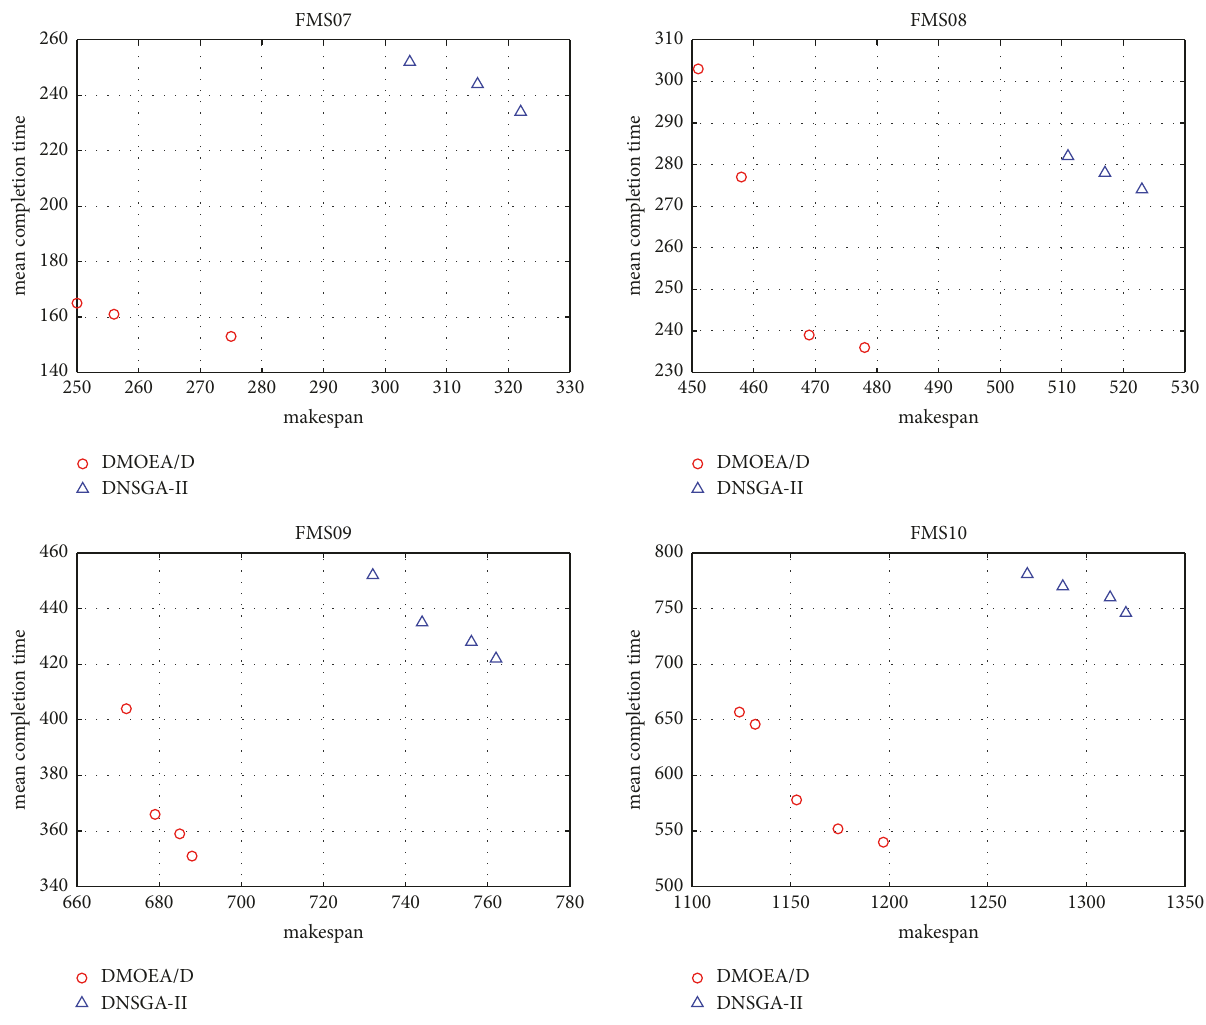
Figure 3: Nondominated solutions of 2-objective problem on instances FMS07-FMS10.